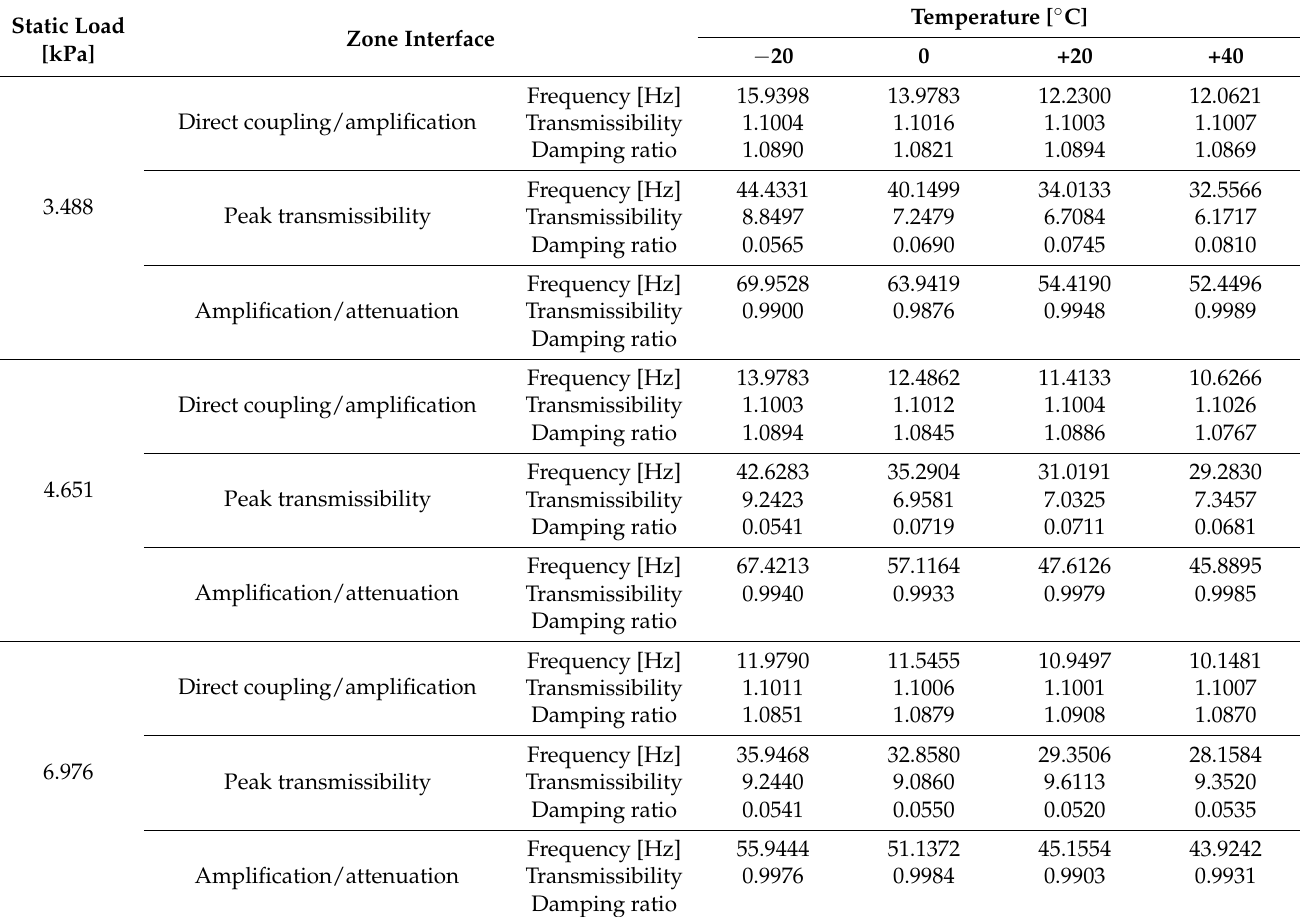
Table 2. Vibration transmissibility and damping ratio of PE25 cushion material.